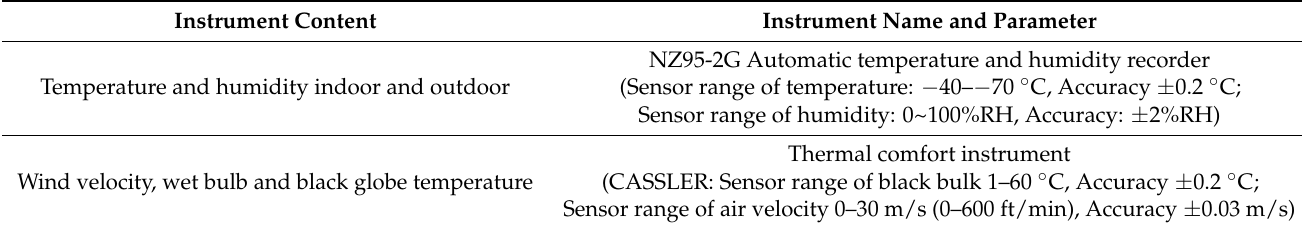
Table 2. The technical specification of the instruments’